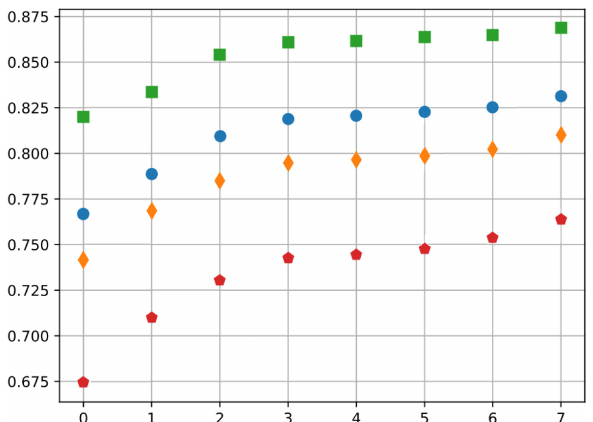
Figure 5. OA (blue), BA (orange), F 1 cloud (green), F 1 clear (red); number i indicates use of set of features {0,…, i -1, i }.